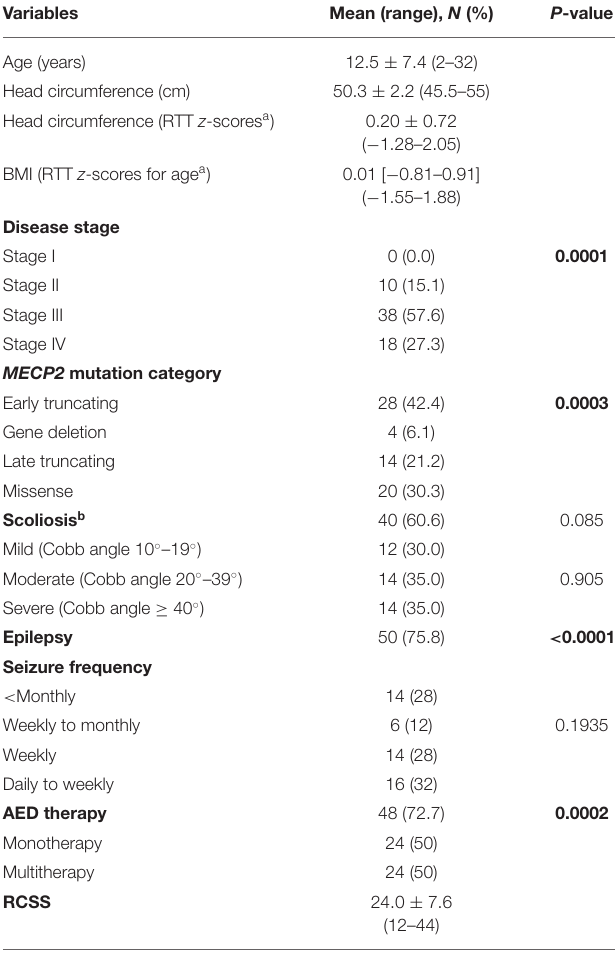
TABLE 1 | Demographic and clinical characteristics of the examined patients with Rett syndrome (RTT) ( n = 66).